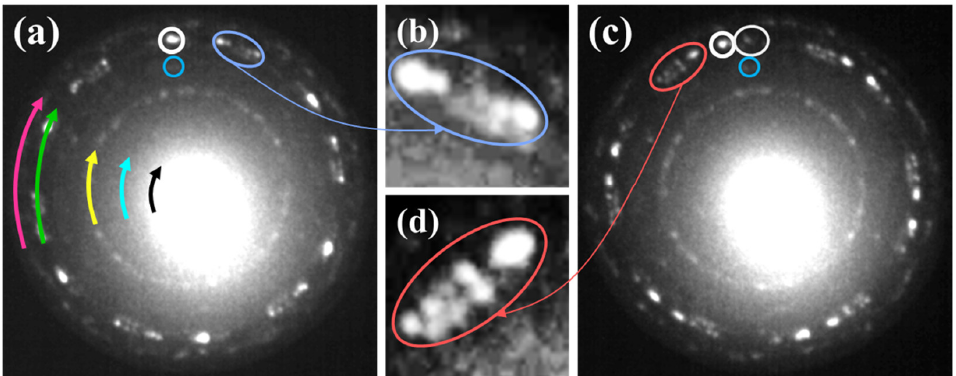
Figure 6. LEED patterns of silicene (pink arrow—low buckled phase, green arrow—planar phase) recorded at 530 K ( a ) and 535 K ( c ), E = 14.2 eV. Additional diffraction spots related to numerous domains of silicene with larger lattice constant visible in the enlarged regions of patterns ( b , d —violet and purple ellipse). Position of selected single diffraction spot (white circle) and the groups of other diffraction spots (violet, purple and white ellipse) in relation to fixed position of barely visible spots of (6 × 6)Au superstructure marked by blue circle show dynamics of the system ( a , c ). Relatively intense Si(111) (√3 × √3) periodicity visible as ring is marked by yellow arrow ( a ). The diffraction spots of the other two periodicities: (√7 × √7) and (√21 × √21), were very weak, cyan and black arrows, respectively.